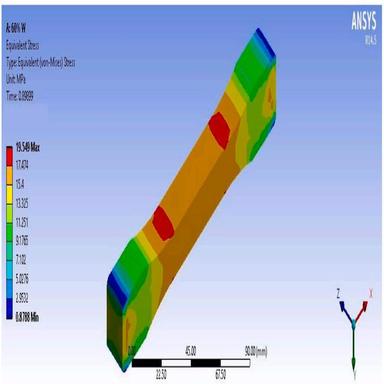
Equivalent stress distribution of Citrus limetta peel powder Composites on tensile specimen.